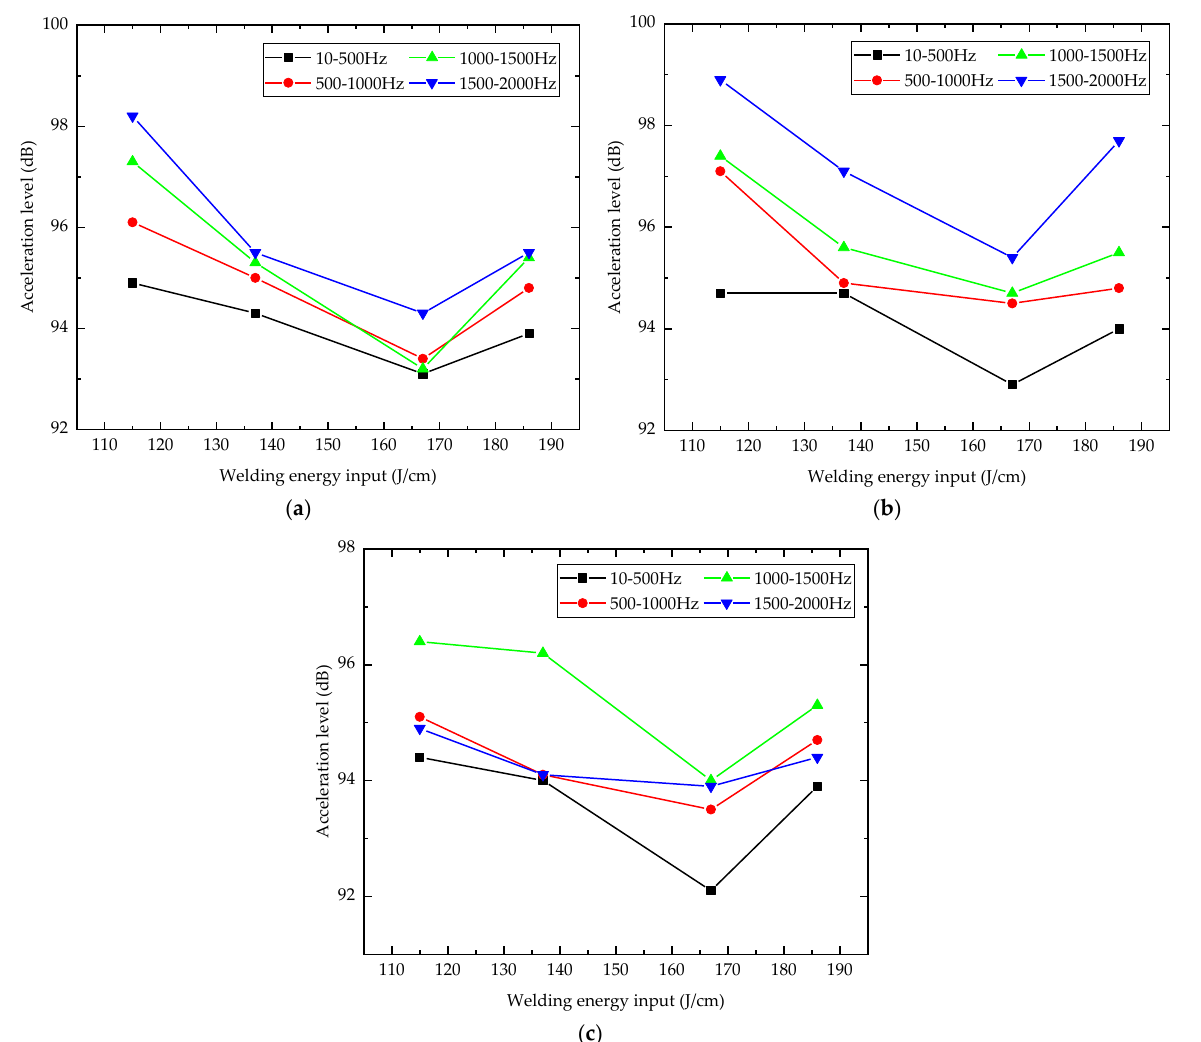
Figure 11. Influence of welding energy input on structural vibration at different measuring points. ( a ) Measuring point A1; ( b ) measuring point A2; ( c ) measuring point A3.